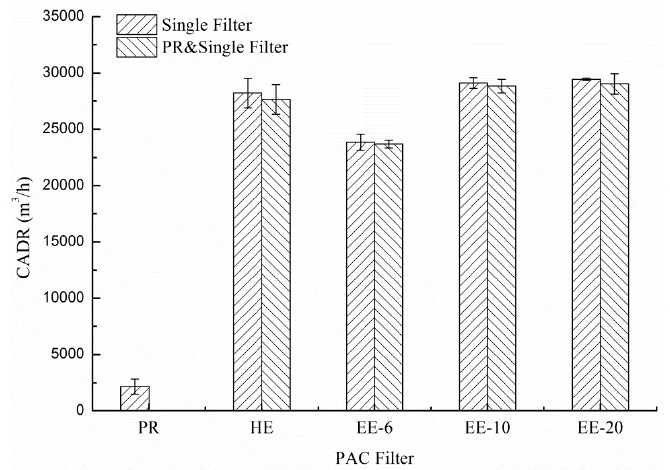
Figure 11. CADRs with and without PR filter, according to single filter.